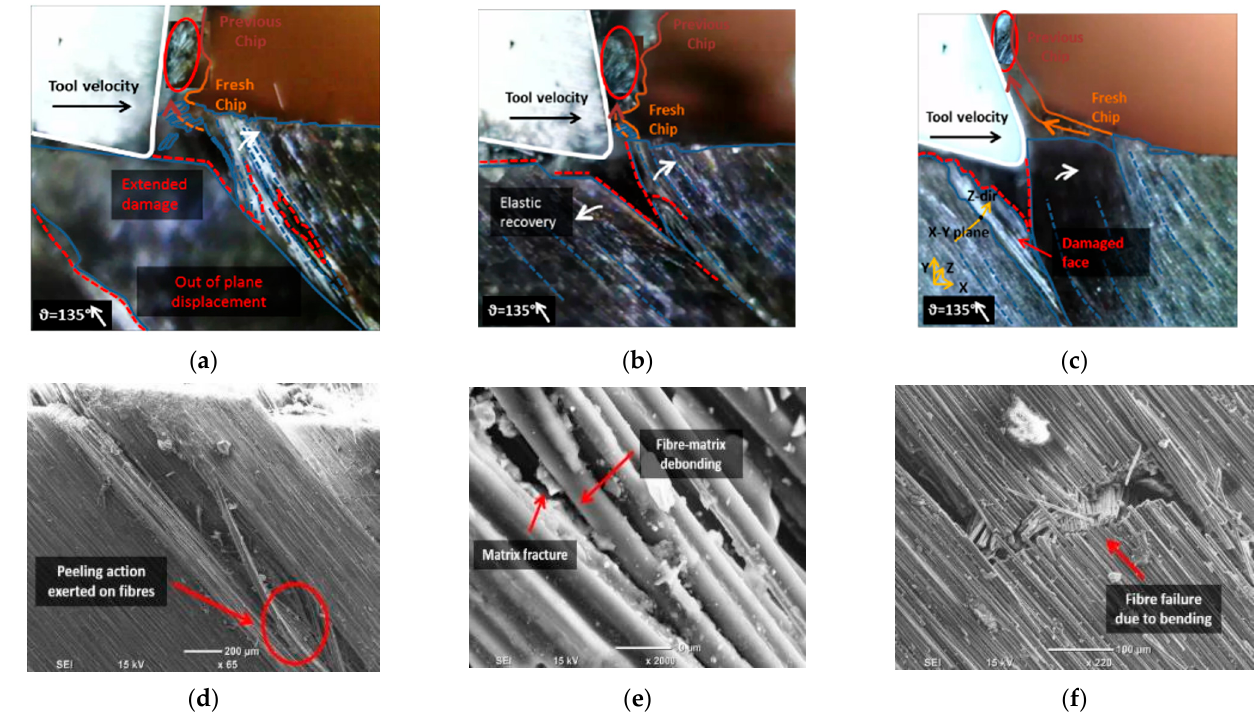
Figure 12. Chip formation at fibre orientation 135° and tool rake angle of ( a ) − 10°; ( b ) 10°; ( c ) 30°; and ( d,e,f ) workpiece damage on the side view.